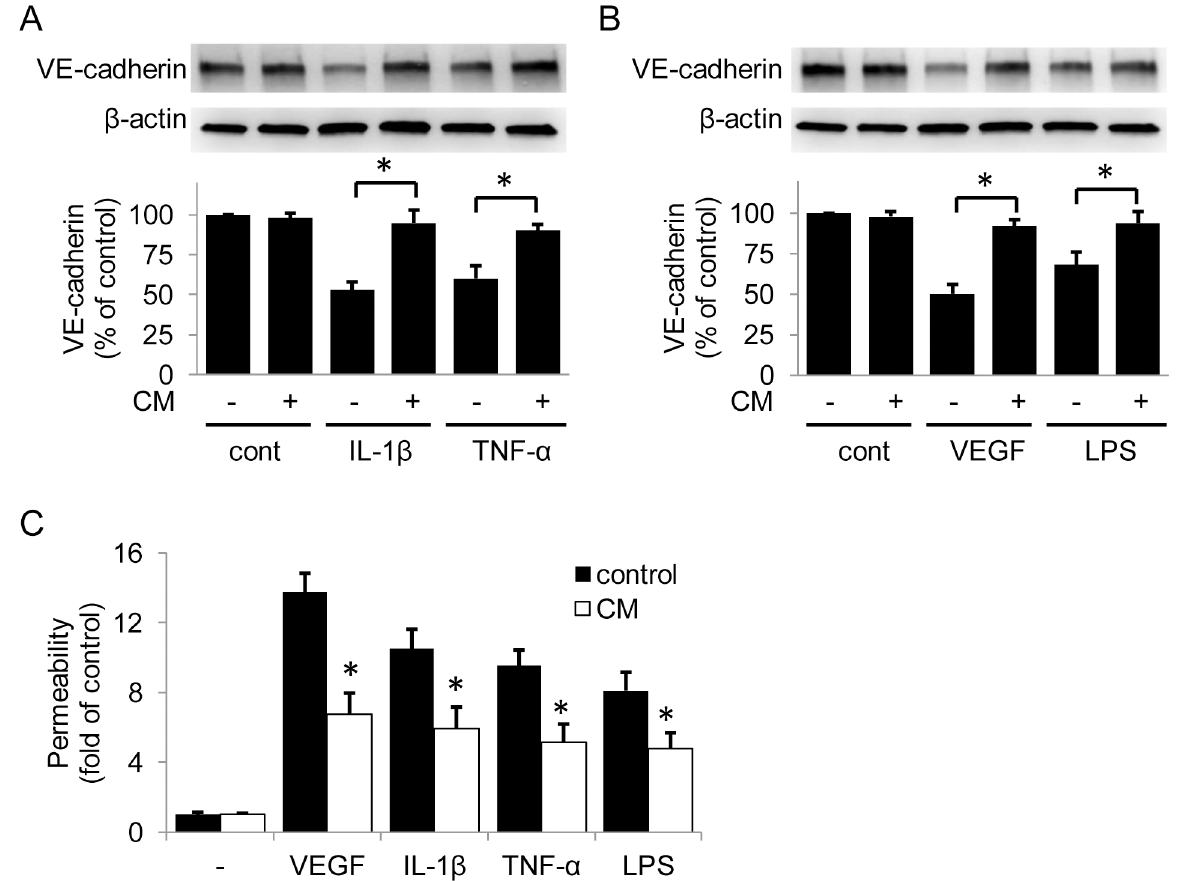
Fig 4. HUVEC-CM prevents VE-cadherin reduction and endothelial hyperpermeability induced by pro-inflammatory mediators. (A) and (B) HUVEC-CM protected VE-cadherin from VEGF and pro-inflammatory cytokines. The upper panel shows a representative Western blot and the lower panel the densitometry. * indicates P < .05. (C) Analysis of HUVEC-CM effect on endothelial permeability by an in vitro permeability assay with FITC-labeled dextran. Each bar denotes mean ± SD of three independent experiments. * indicates P < .05.